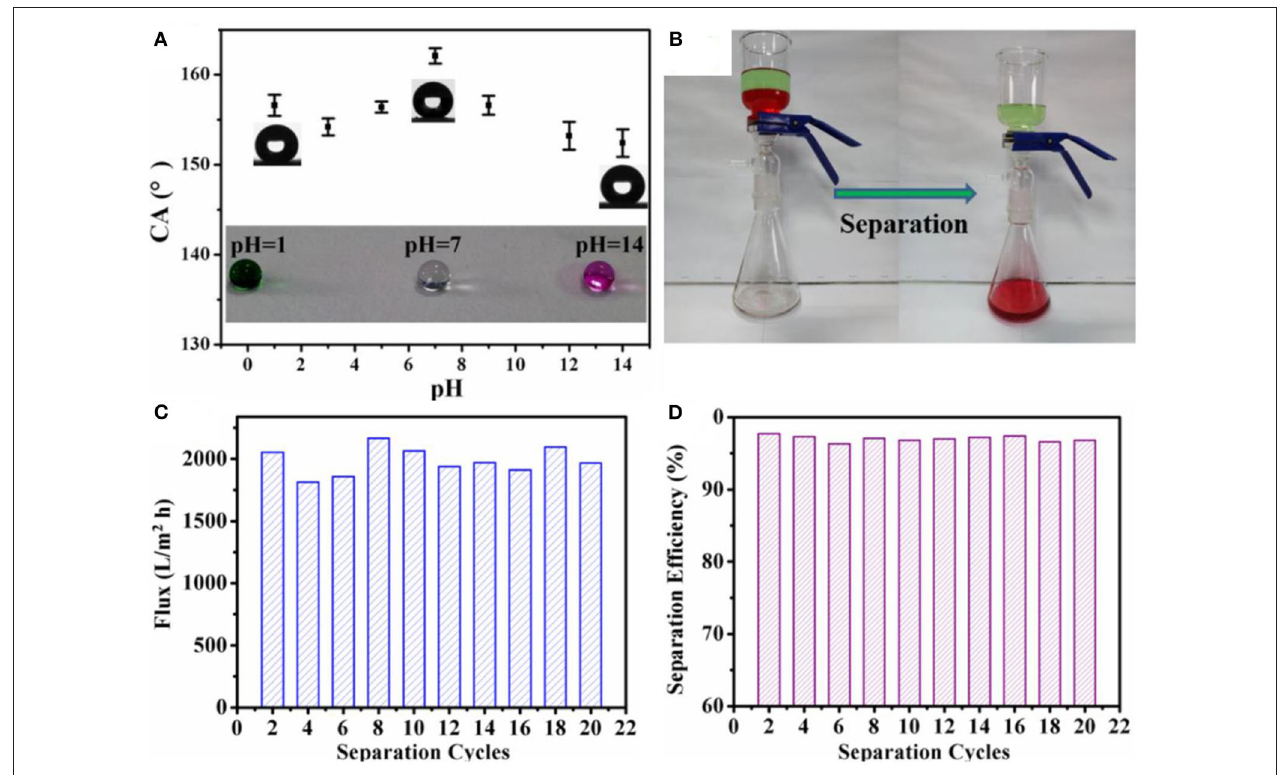
FIGURE 7 | (A) Graph showing the variation of water contact angles at different pH values, whereas the shape of water droplets can be observed in the inset. (B) Separation of dichloromethane and water under harsh conditions. The (C) flux and (D) efficiency for the oil-water separation with different cycles by using the polyvinylidene fluoride (PVDF)/silica membrane. Adapted from Gao et al. (2017a). With permission from Elsevier, copyright